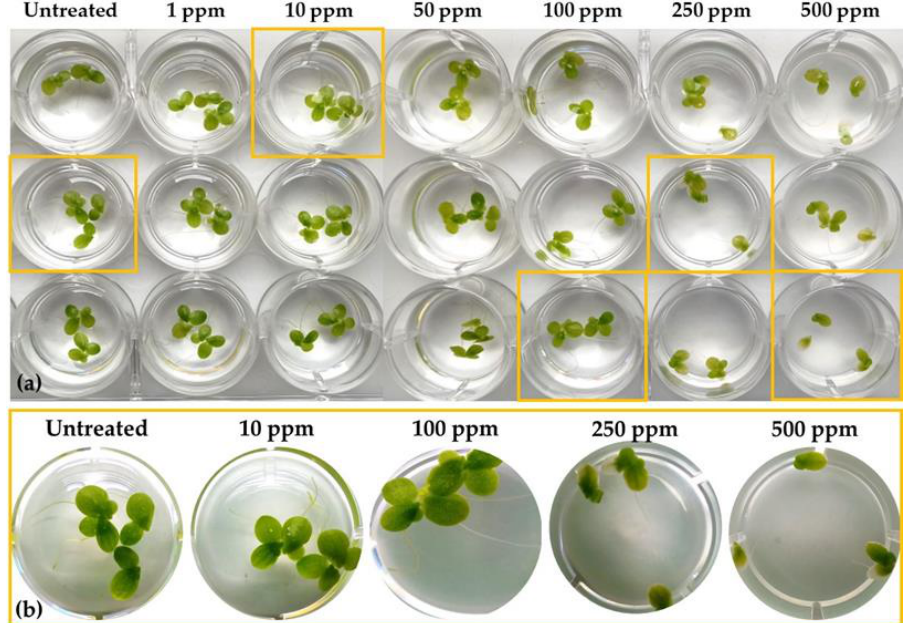
Figure 1. ( a ) Phenotypic observations of Lemna minor L. cultures 72 h post-treatment with the Bacillus sp. PTA13 lipopeptide extract. The extract was applied at the concentrations of 1, 10, 50, 100, 250, and 500 µ g · mL − 1 , performing three biological replications per treatment. ( b ) Magnification of representative treatments enables the visualization of the effects of the lipopeptide extract on the plant.